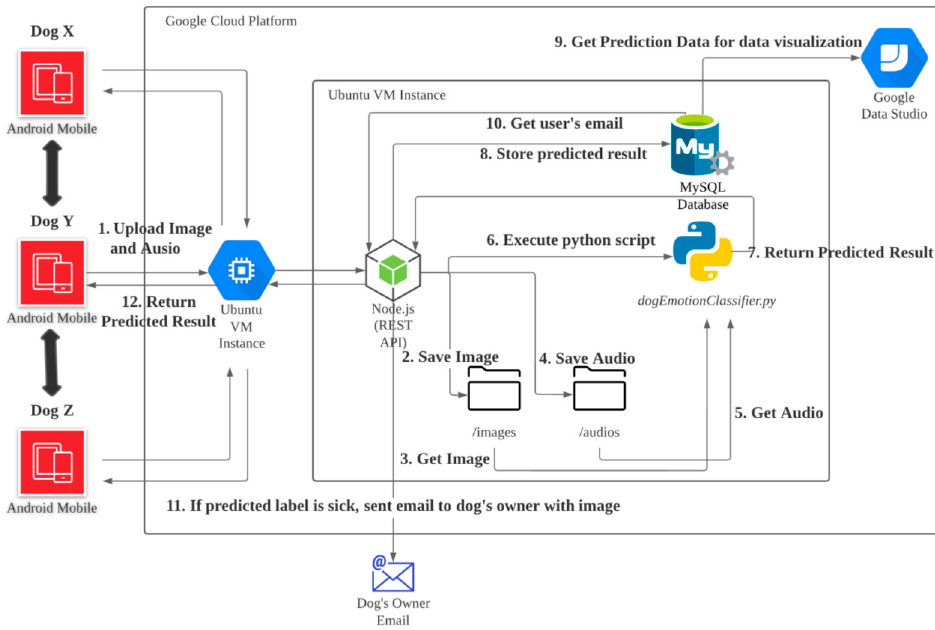
Figure 1. The proposed cloud-based smart environment dogs’ social network architecture.